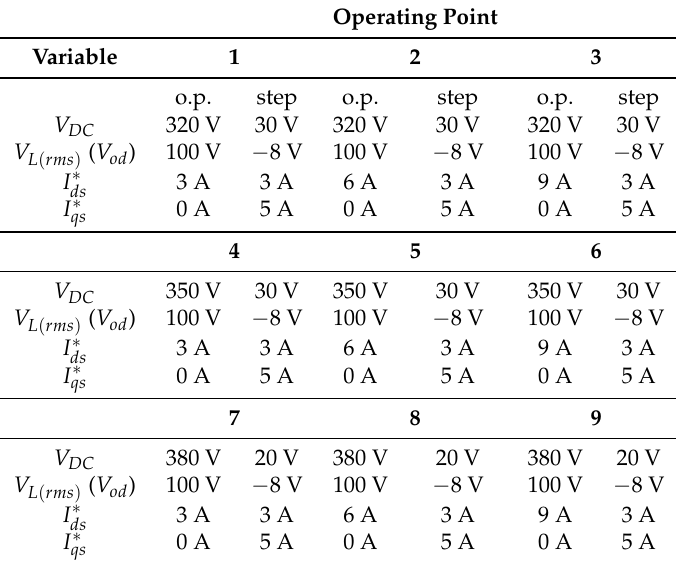
Figure 11. Polytopic model scheme for three operating points. Table 2. Operating point setup and step